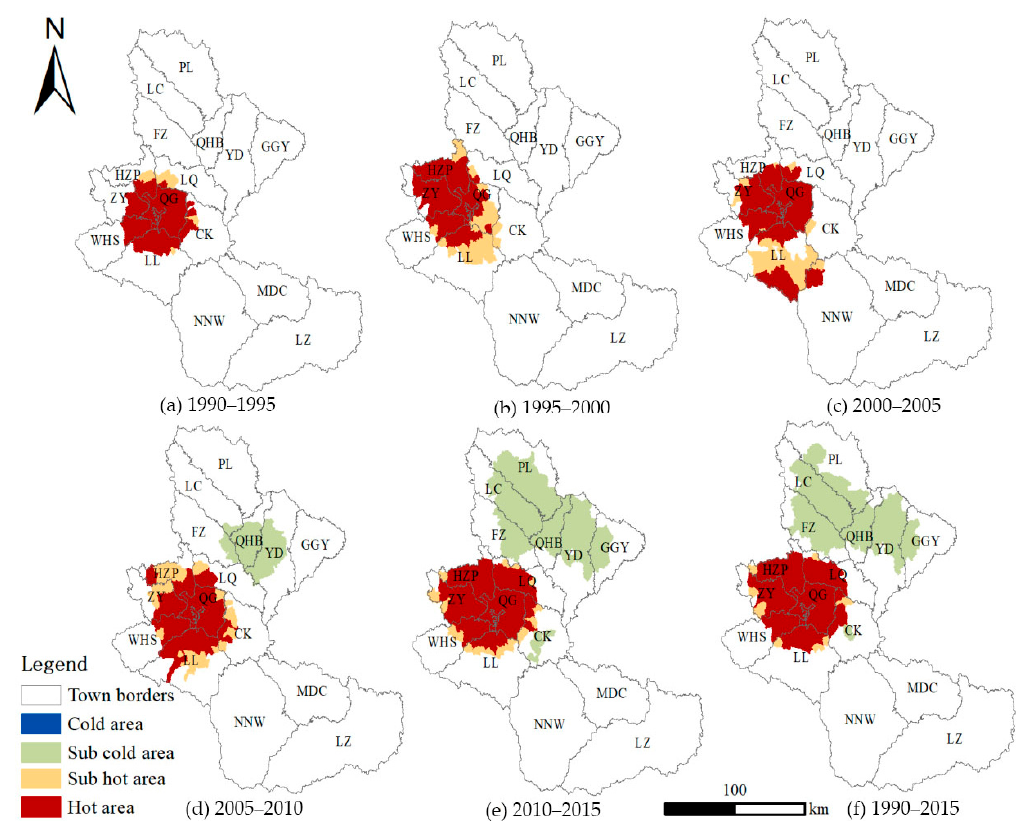
Figure 4. Spatial distribution of rural residential land expansion hotspot areas for the years ( a ) 1990–1995; ( b ) 1995–2000; Qinghuabian, YD: Yaodian, GGY: Ganguyi, LQ: Liqu, QG: Qiaogou, HZP: Hezhuangping, ZY: Zaoyuan, WHS: Wanhuashan,